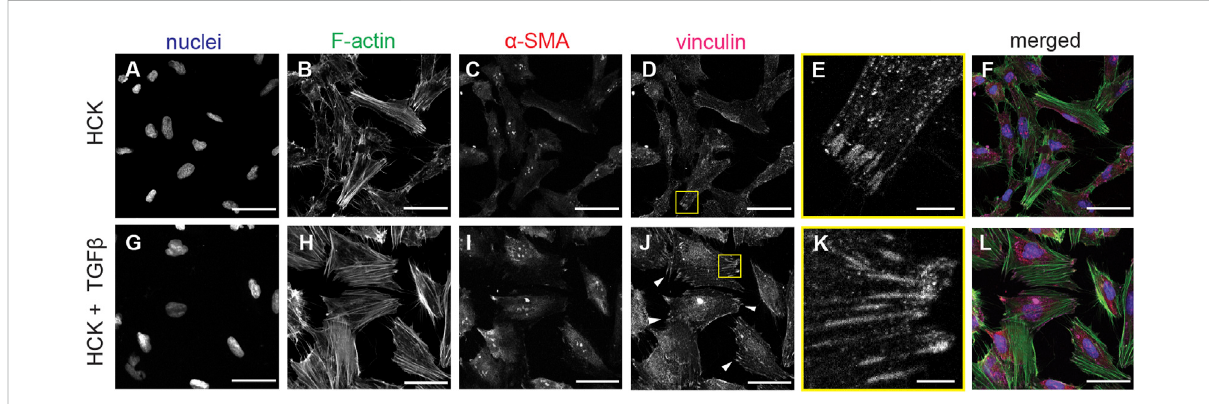
FIGURE 4 F-Actin and vinculinlocalization inHCK and HCK + TGF β cells. (A – F) HCK cells and ( G – L )HCK + TGF β cells stained for (A,G) nuclei (Dapi, blue), (B,H) F-actin (phalloidin, green), (C,I) α -SMA (red), and (D,J) vinculin. Scale bars: 50 µm. (E,K) Zoom-in views of (D) and (J) , respectively, showing the formation of focal adhesions. Scale bar: 5